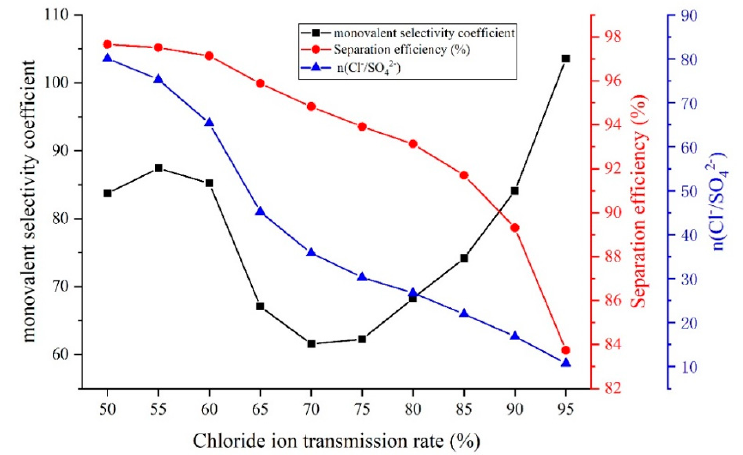
Figure 11. Trends of each index in electrodialysis process.